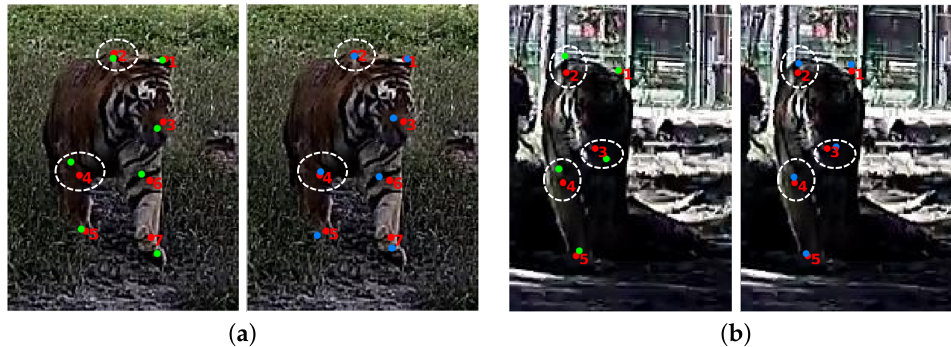
Figure 1. ( a , b ) are examples from the Amur dataset. The red point represents ground truth, which is annotated by us according to the ATRW [24] definition. The number represents the index of the joint [24]. The green point represents the initial pose estimated by HRNet [25]. The blue point represents the refined pose, which is obtained via the postprocessing of the initial estimation using the proposed method. The dashed circles indicate significant